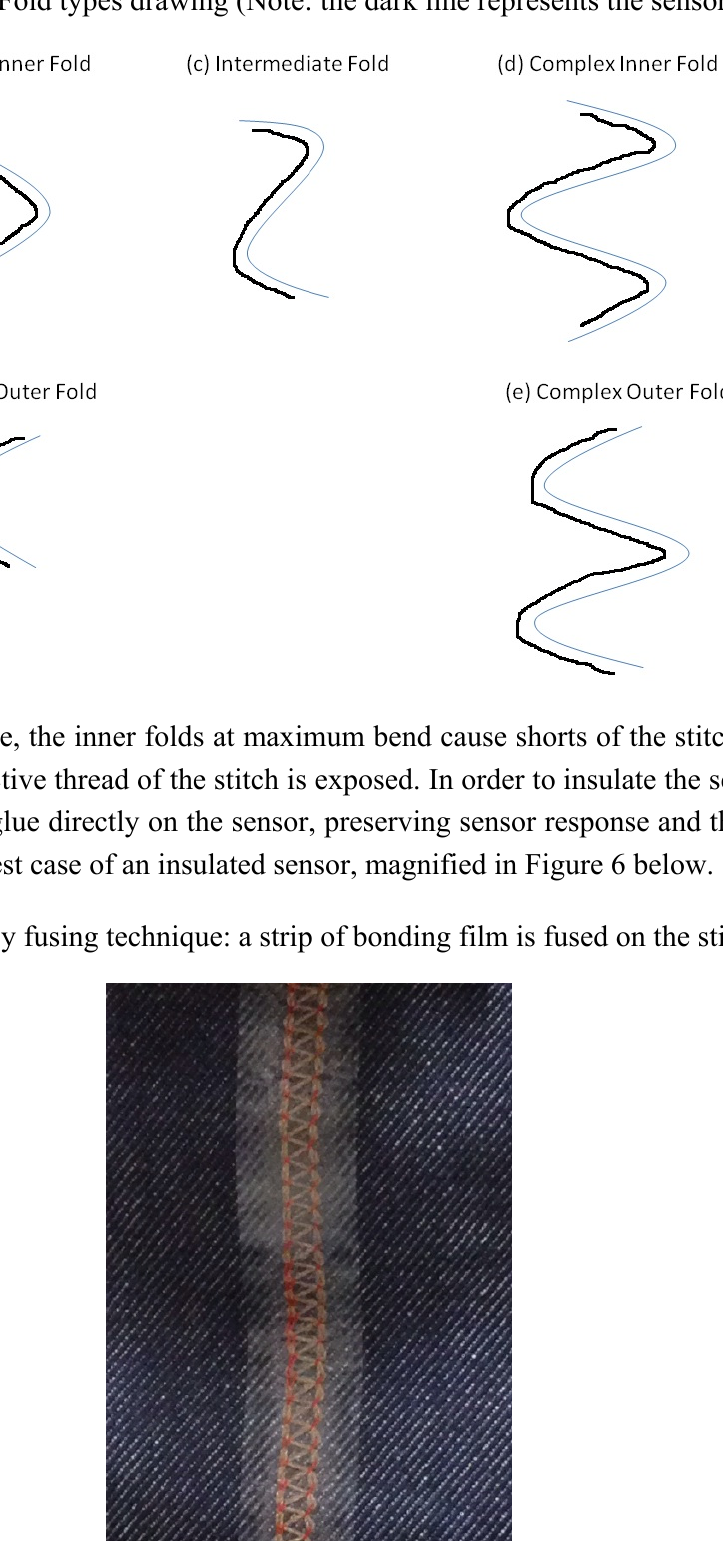
Figure 5. Fold types drawing (Note: the dark line represents the sensor).